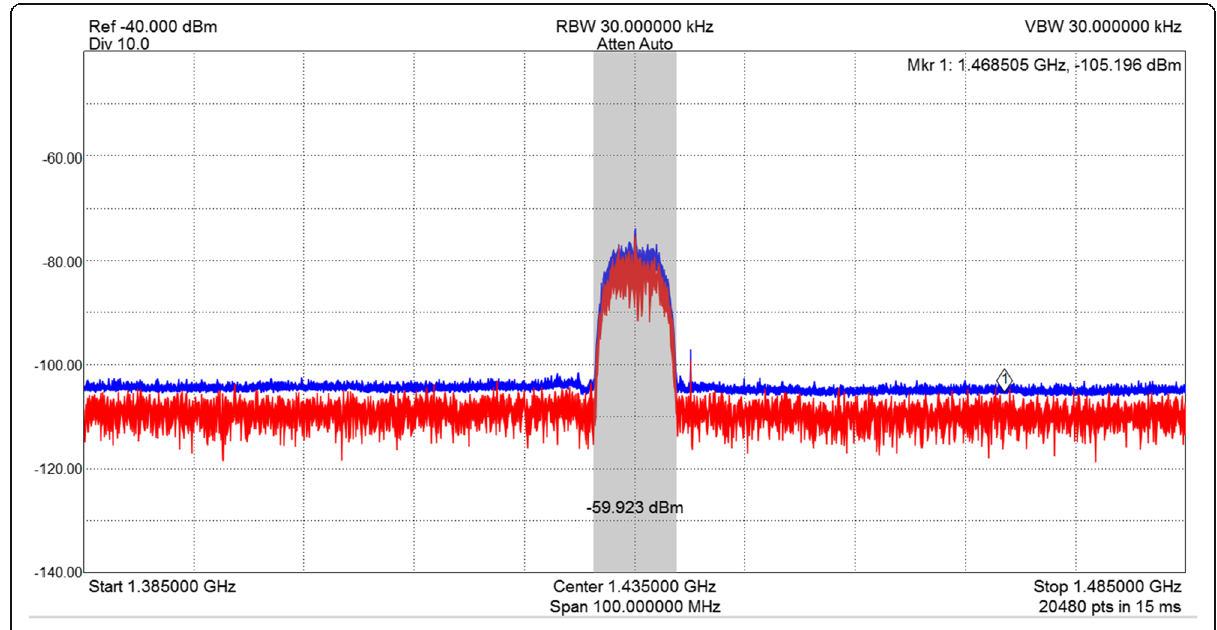
Fig. 18 The transmitting and receiving frequency spectra. Joint testing is also performed for the transmitting signals and the receiver, with the transmitting and receiving frequency spectra